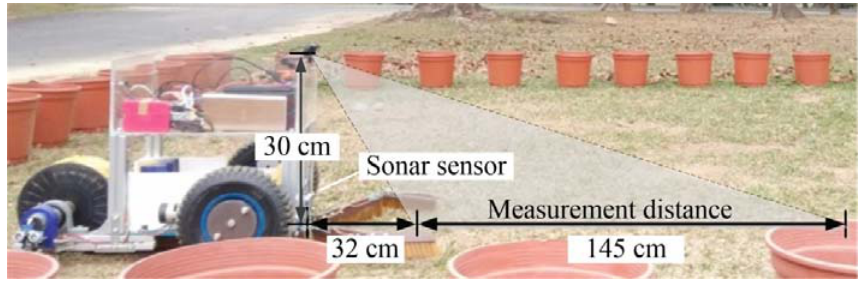
Figure 12. Determination of the visual and ultrasonic detection range for the robot.